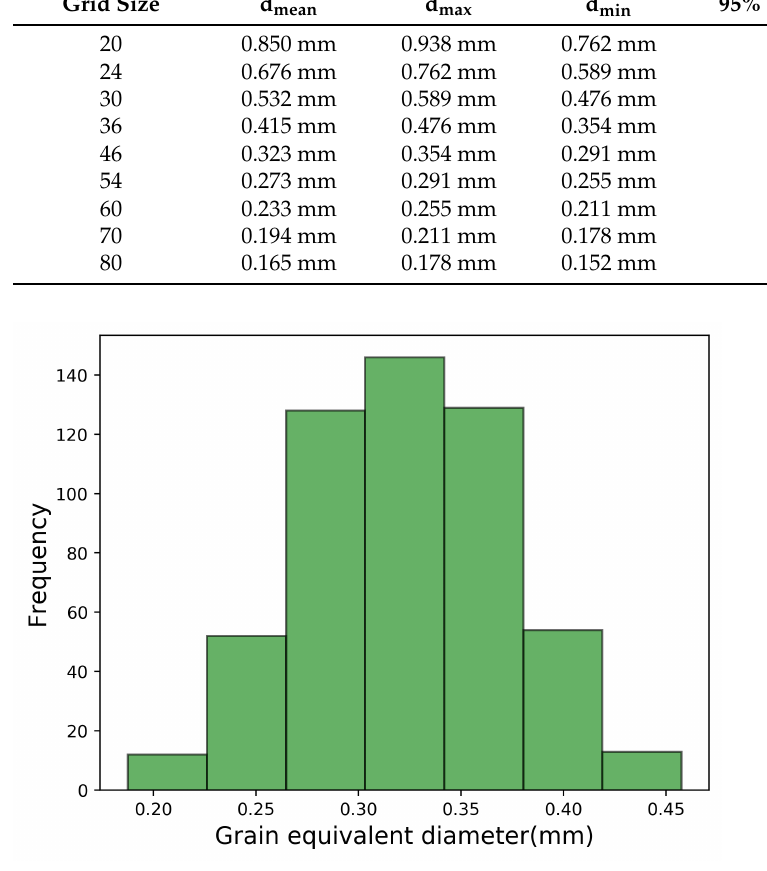
Figure 16. Distribution of grain size for grit